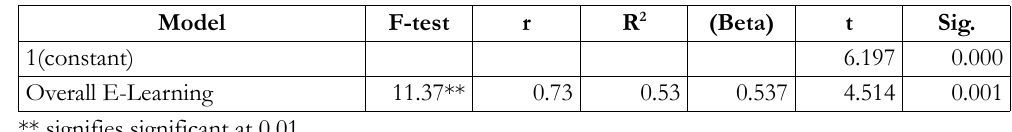
Table 4. Test the value of Kolmogorov-Smirnove for distribute